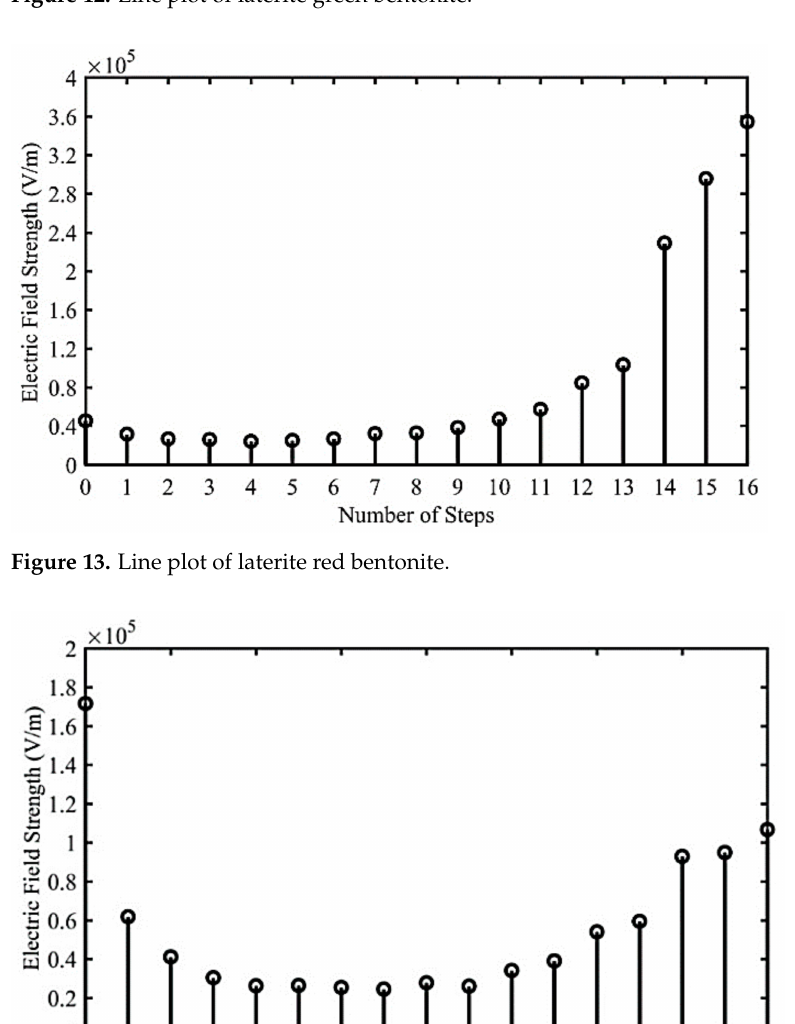
Figure 12. Line plot of laterite green bentonite.